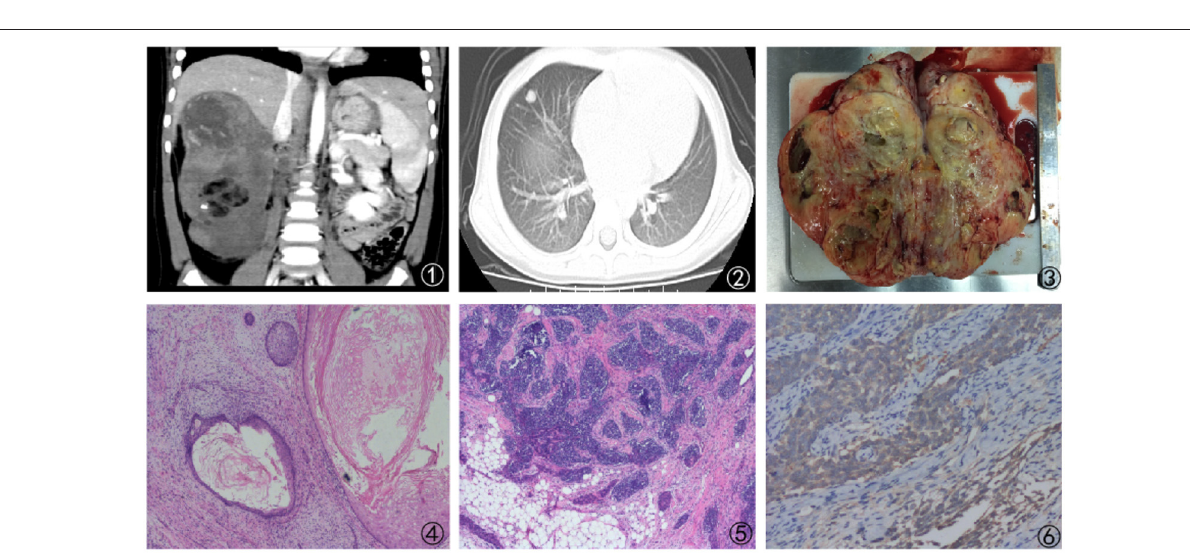
FIGURE 4 | Findings from a 38-month-old girl presenting with abdominal pain for 1 week. (1) Abdominal CT scan revealing a large mass that had almost fully replaced the right kidney; (2) Lung metastases as revealed by the presents of a large lesion in the right lung; (3) Cross-sectional surface of the kidney, exhibiting a large mass that had largely replaced the normal tissue compartment; (4, 5) Imaging findings revealing prominent heterologous components that include squamous epithelial cells; (6) Positive WT-1 immunostaining in intratumoral